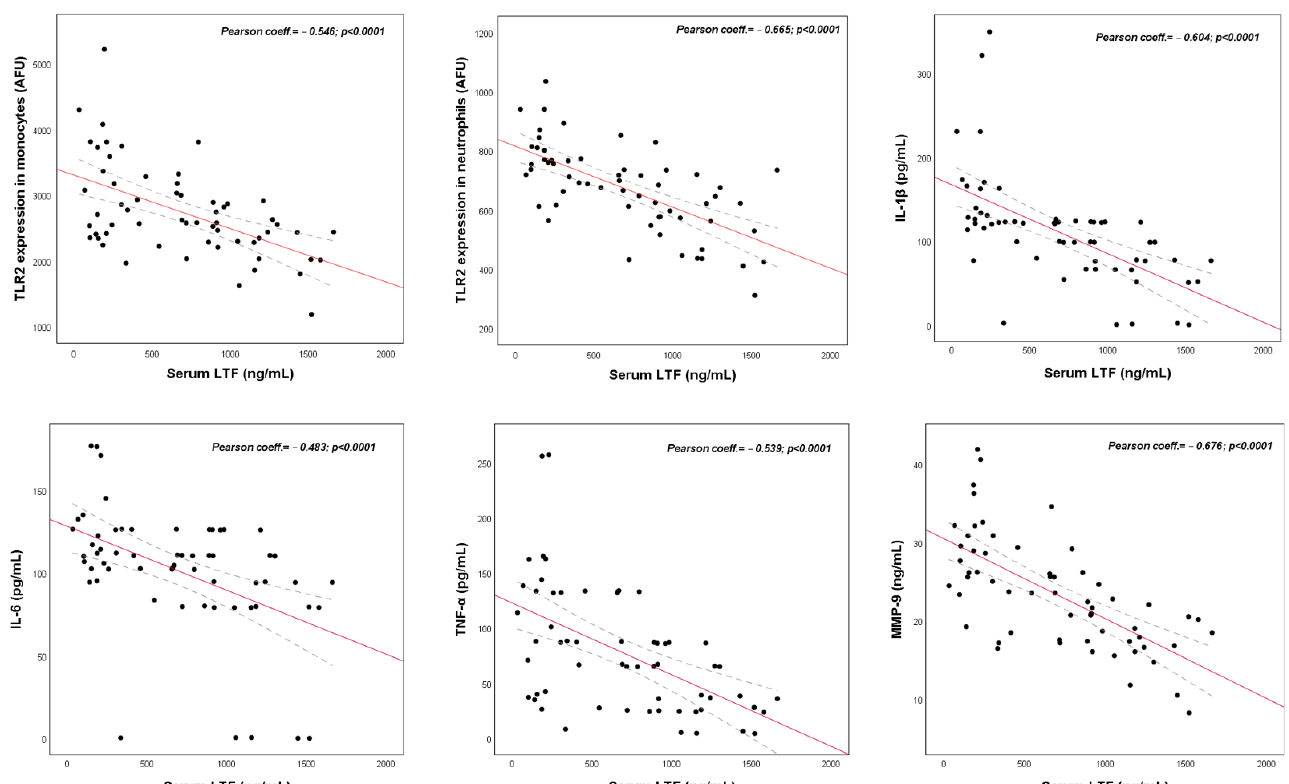
Figure 2. Scatter plots between serum LTF levels and immune–inflammatory biomarkers studied in blood samples showed a strong negative correlation for all of them. Abbreviations: AFU, arbitrary fluorescence units; IL, interleukin; LTF, lactoferrin; MMP-9, matrix metalloproteinase 9; TLR2, Toll- like receptor 2; TNF- α , tumor necrosis factor-alpha. Legend: the black dots represent the study cases, the grey dotted lines represent the mean confidence intervals, and the red line represents the linear fit line. Table 1. Correlations (Pearson’s coefficients) between tear LTF concentrations and ocular mark- ers (TLR2 expression in corneal and conjunctival epithelial cells, and other corneal topographic, aberrometric, and tomographic parameters). Tear LTF/Ocular Markers Pearson’s Coefficient, p Value